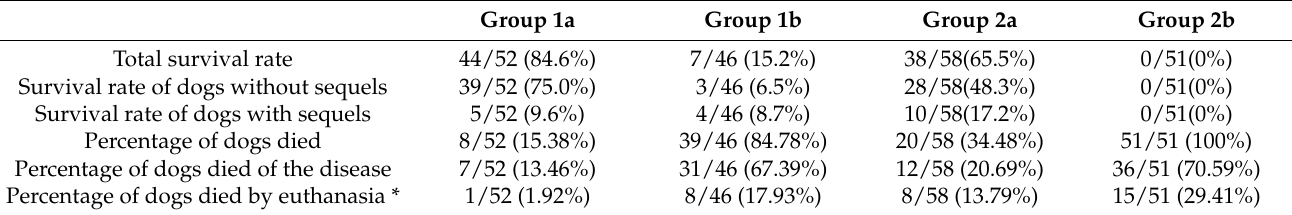
Table 4. Survival and death rates for the study